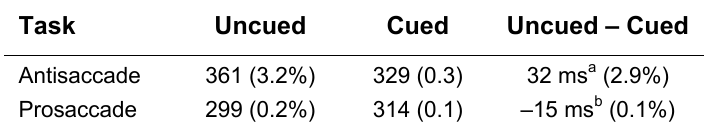
Mean Response Times and (% Error) from